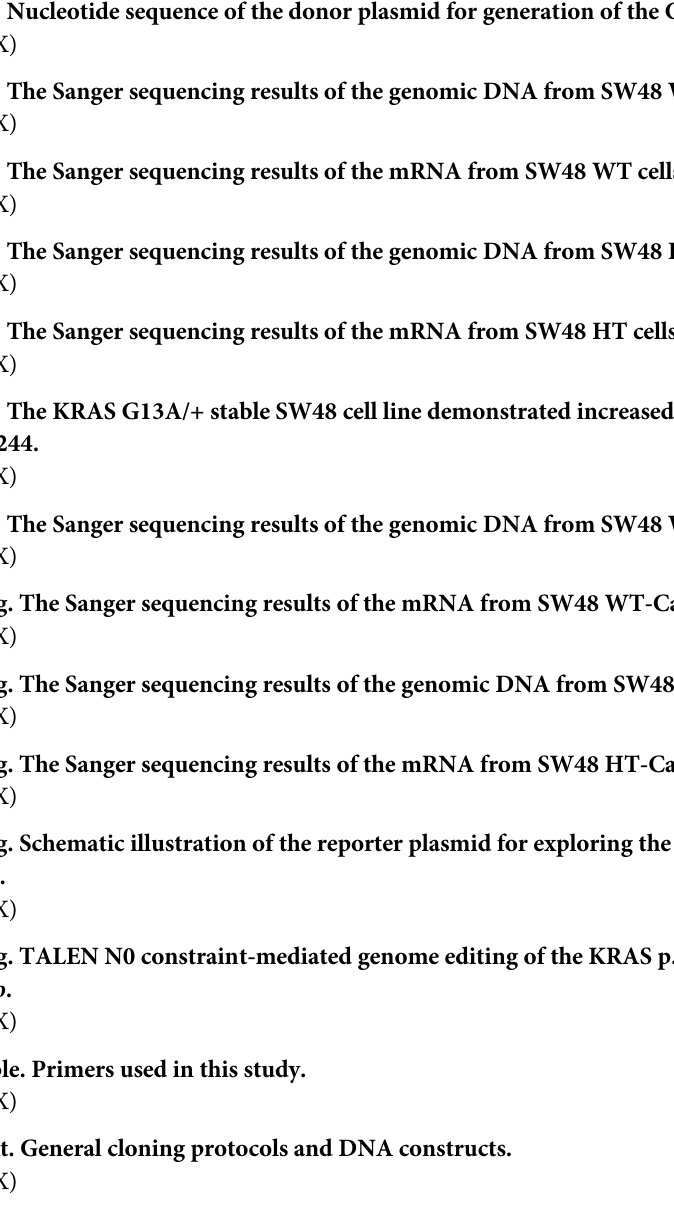
S3 Fig. Nucleotide sequence of the donor plasmid for generation of the G13A/+ SW48 cells. S4 Fig. The Sanger sequencing results of the genomic DNA from SW48 WT cells. S5 Fig. The Sanger sequencing results of the mRNA from SW48 WT cells. S6 Fig. The Sanger sequencing results of the genomic DNA from SW48 HT cells.